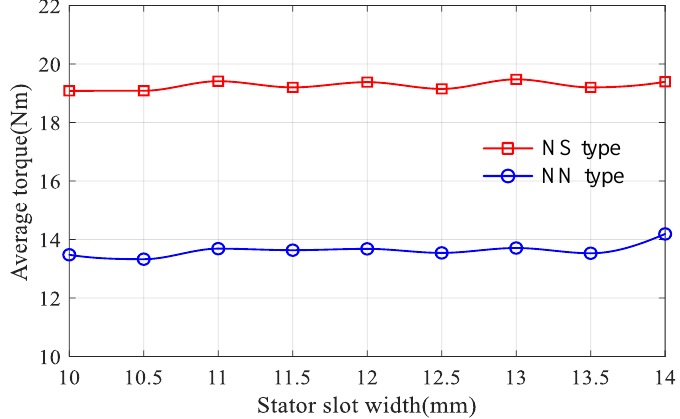
Figure 5. Influence of stator slot width on average torque.